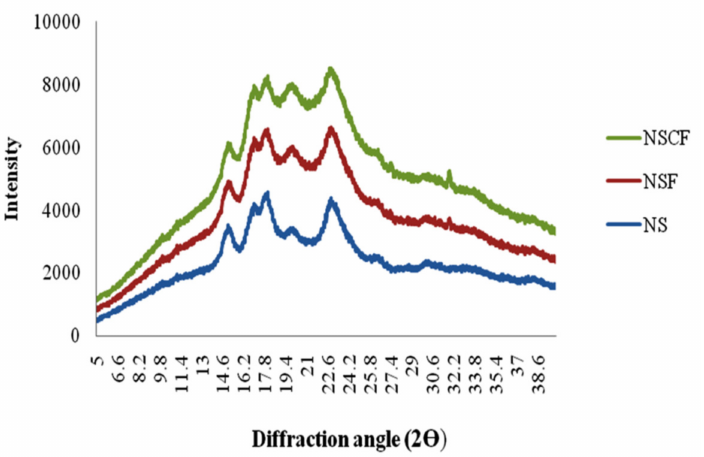
Figure 7. X-ray diffraction of proso millet starch, native film (NSF), and k-carrageenan film